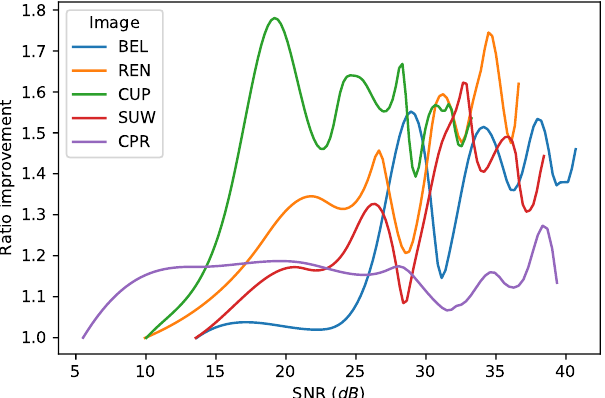
Figure 6. Relationship between the compression ratios of the compressed images at a given SNR when using pattern 8 to shave bits. DHO image is omitted since it was an outlier with about 8 × improvement.